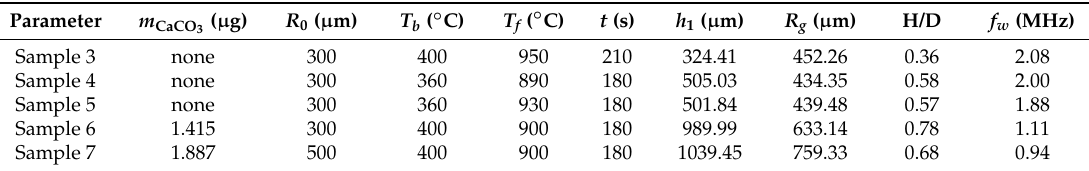
Table 3. The simulation results of four-node wineglass resonant frequencies.